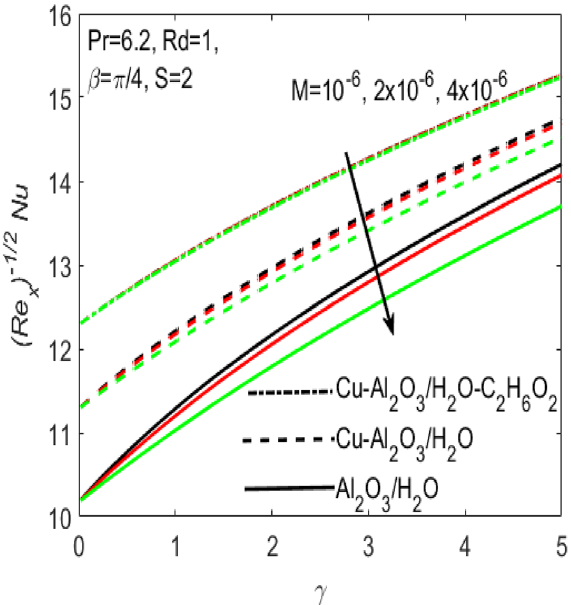
Figure 10. Influence of M on Nu for different hybrid nanofluids and simple nanofluid.